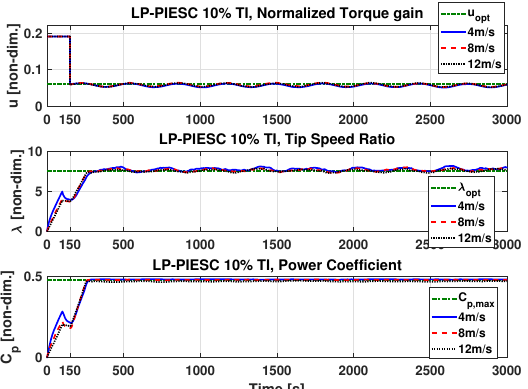
Figure 8. Performance of LP-PIESC with the parameters shown in Table 3 and hub-height wind from Figure 6. Normalized torque gain u ( top ), tip speed ratio λ ( middle ), estimated power coefficient C p ( bottom ). The dashed horizontal lines indicate optimal parameters u opt , λ opt and C P ,max . The LP- PIESC is turned on at 150